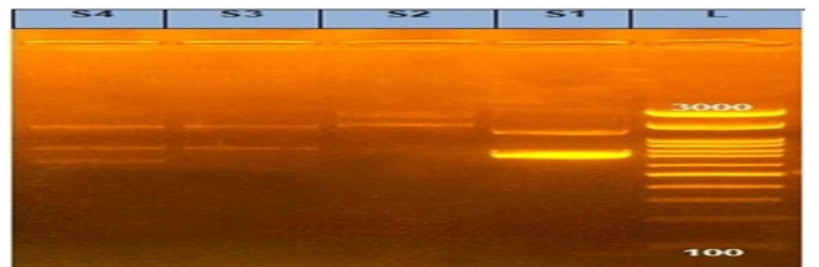
Figure 3. Agarose gel showing amplified products of variable integrons in Salmonella isolates. L: DNA ladder 100 bp and Lanes (S1, S2, S3, and S4) examined Salmonella isolates (S1: S. Kentucky from calf and S2: S. Kentucky from chicken) and (S3: S. Entertidis from chicken and S4: S. Enteritidis from the calf).